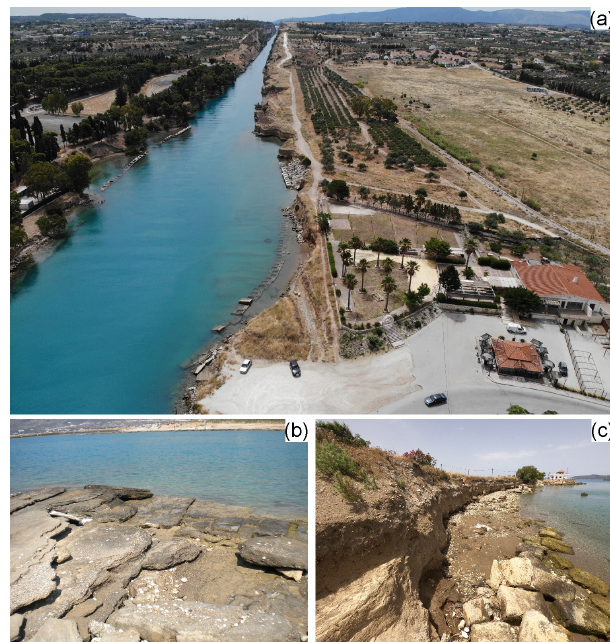
Figure 4. (a) A panoramic view of the western part of the isthmus. Diolkos can be seen on the right. (b) The younger beachrock is vis- ible covering part of Diolkos paved road. According to Pirazzoli et al. (2012), two different subsidence phases and an intermediate uplift can be distinguished. (c) The area of Diolkos suffers from in- tense coastal erosion, and a large part of Diolkos has been destroyed due to erosion, while the coast is under a continuous coastal retreat mainly due to the waves generated by large